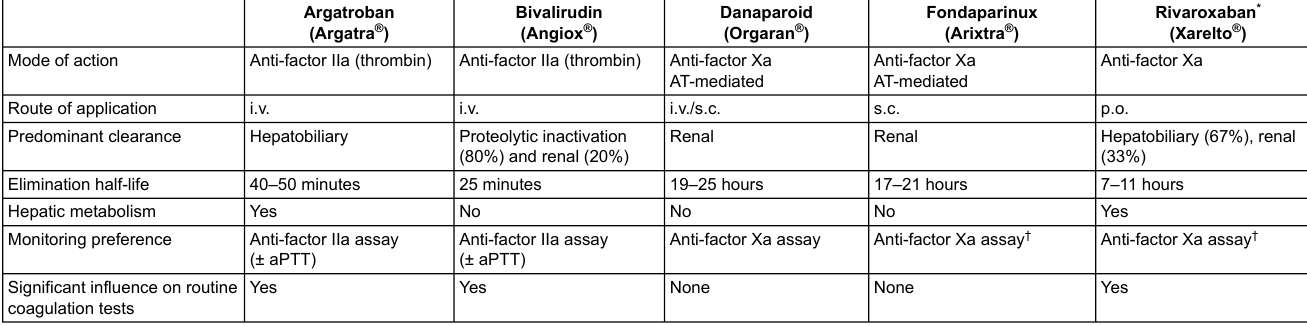
Table 1: Properties of anticoagulants used for the treatment of heparin-induced thrombocytopenia.